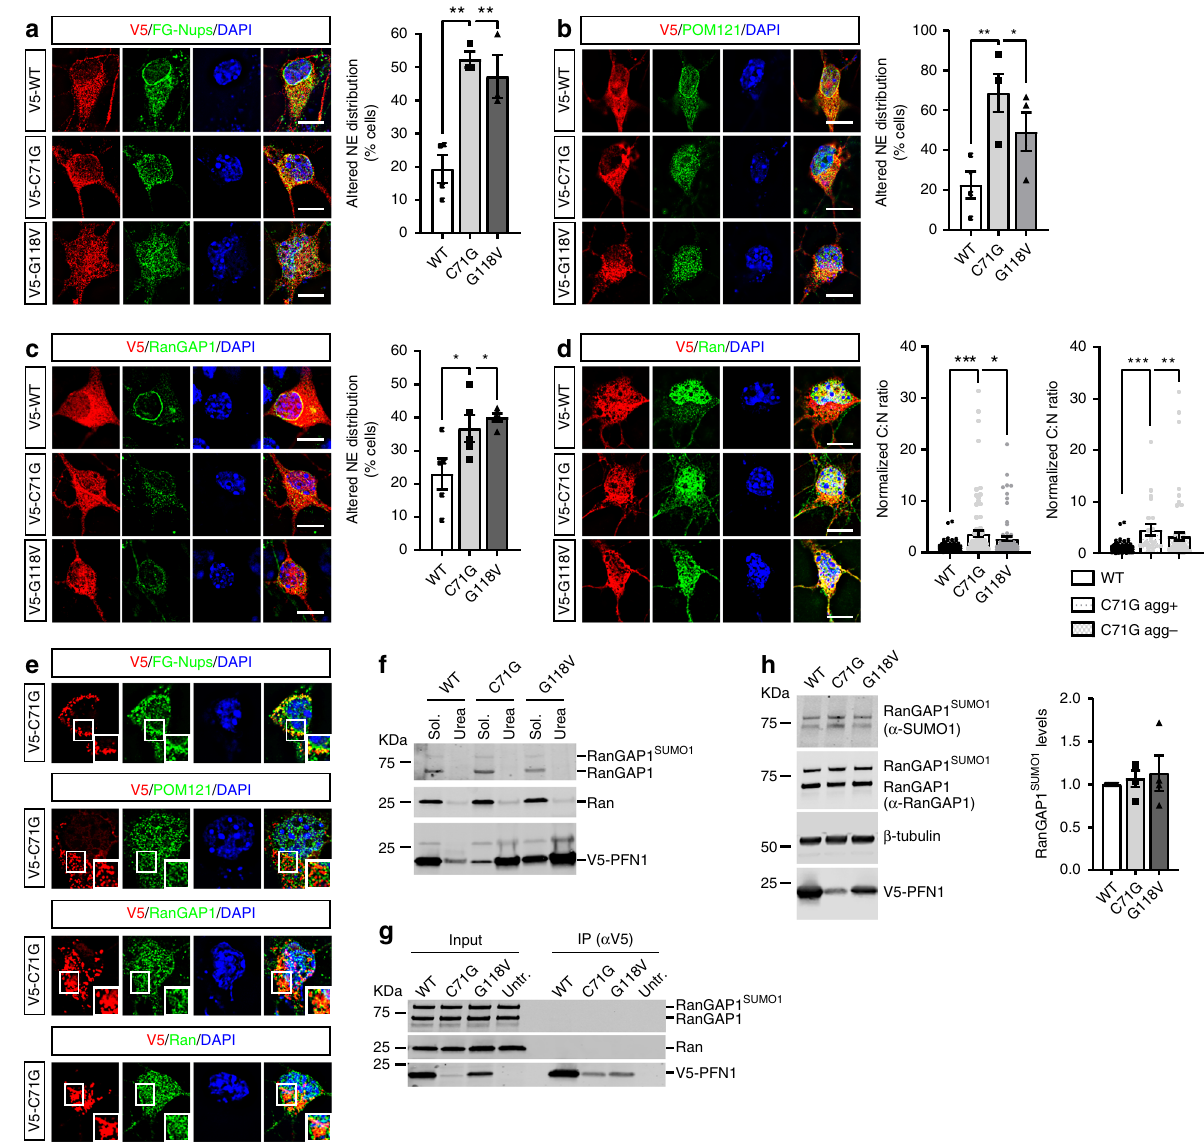
Fig. 1 Mutant PFN1 alters the composition and density of NPCs. a , c Antibody against FG-Nups ( a , green; mAb414), POM121 ( b , green), and RanGAP1 ( c , green) localization to the NE (identi fi ed based on DAPI staining) is altered in a higher percentage of MNs expressing V5-tagged mutant PFN1 vs PFN1 WT control (red). d Ran (green) cytoplasm to nucleus (C:N) ratio is increased in MNs expressing V5-WT or mutant PFN1 (red), regardless of the presence of aggregates (agg), indicating possible functional defects in the segregation of cytoplasmic and nuclear proteins. e PFN1 C71G -positive cytoplasmic inclusions (red) as described in Wu et al. (2011) in MNs are not positive for FG-Nups, POM121, RanGAP1, or Ran (green), suggesting no co-aggregation under these conditions. f No difference in the solubility of Ran (middle panel) or RanGAP1 (top panel) caused by the expression of PFN1 mutants when assayed in HEK293 cells using detergent-based cellular fractionation. Triton X-100 (2%) and urea (8M) were used to extract the soluble and insoluble fraction, respectively. g Representative blot of a co-immunoprecipitation (co-IP) assay between V5-tagged WT or mutant PFN1 and RanGAP1 (top panel) or Ran (middle panel). No bands were detected in the IP pellet, suggesting lack of interaction. h Representative western blot and quanti fi cation showing unchanged levels of SUMO1-modi fi ed RanGAP1 in the presence of mutant PFN1. Both antibodies against SUMO1 (top panel) and RanGAP1 (second panel) detect a band ~80 KDa corresponding to SUMOylated RanGAP1. V5 antibody (bottom panel) shows the expression of the V5-tagged PFN1 protein, while β - tubulin was used as a loading control. Bars are mean ± SEM; * p < 0.05, ** p < 0.01, *** p < 0.001. N = 3 – 5 independent experiments ( a – c ), 76 – 103 cells from 6 independent experiments ( d ), 4 independent experiments ( h ). DAPI (blue) was used to detect the nucleus and assess cell health. Scale bars: 10 µ m.